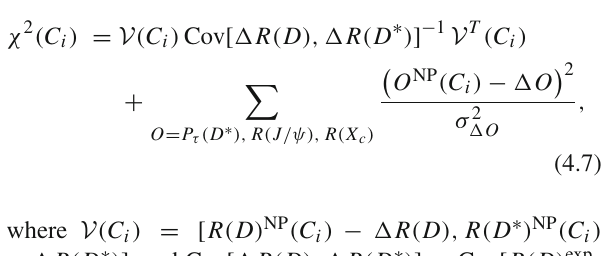
Fig. 2 Constraints on the NP Wilson coefficients in the simultaneous presenceoftwo C i s.Thegreen,cyan,andblueareasareallowedrespec- tively by (cid:21) R ( D ( ∗ ) ) , (cid:21) R ( J /ψ) , and (cid:21) R ( X c ) , all being varied within the 3 σ range of their respective experimental data, while the purple bands are allowed by the upper bound B ( B c → τν) (cid:2) 10%. The red regions are obtained by requiring (cid:21)χ 2 ≤ 11 . 83 near the corresponding